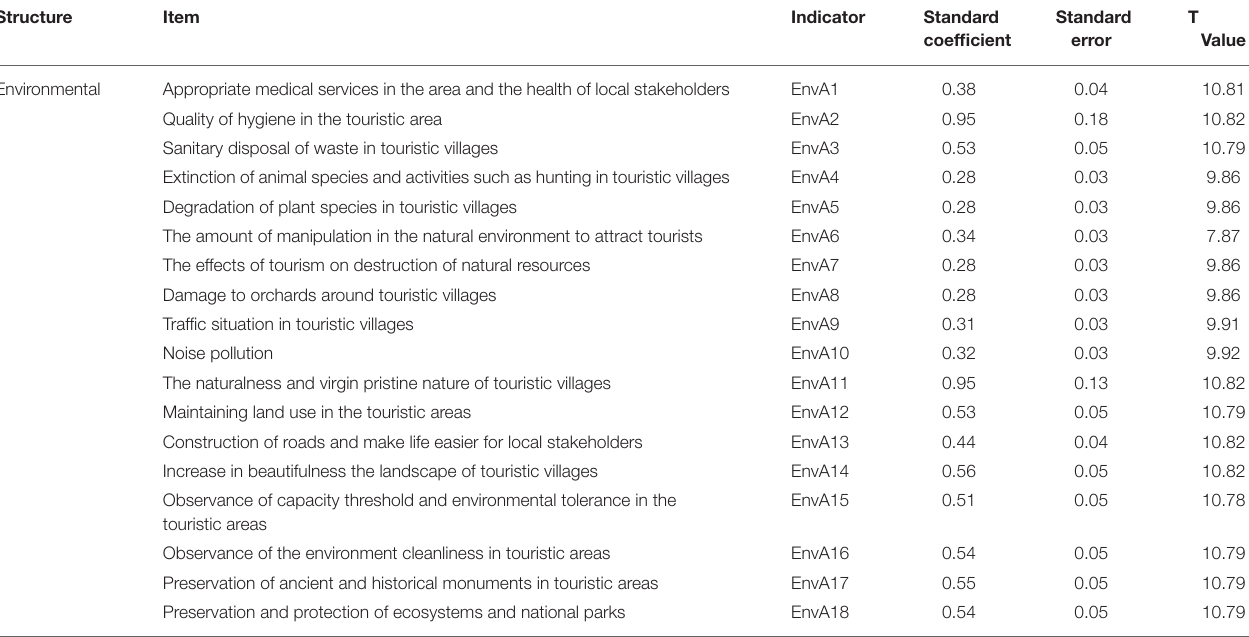
TABLE 3 | Summary of results obtained from the environmental impact model (second-order confirmatory factor analysis). Structure